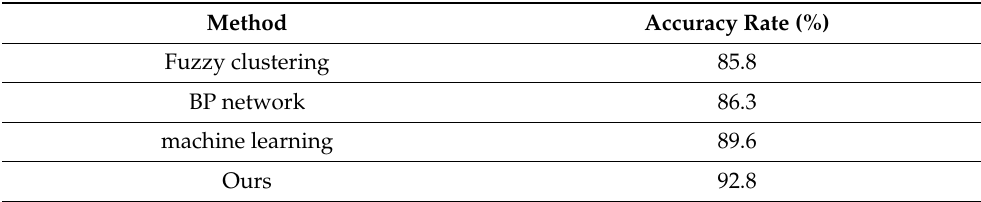
Table 2. Experimental comparisons in different